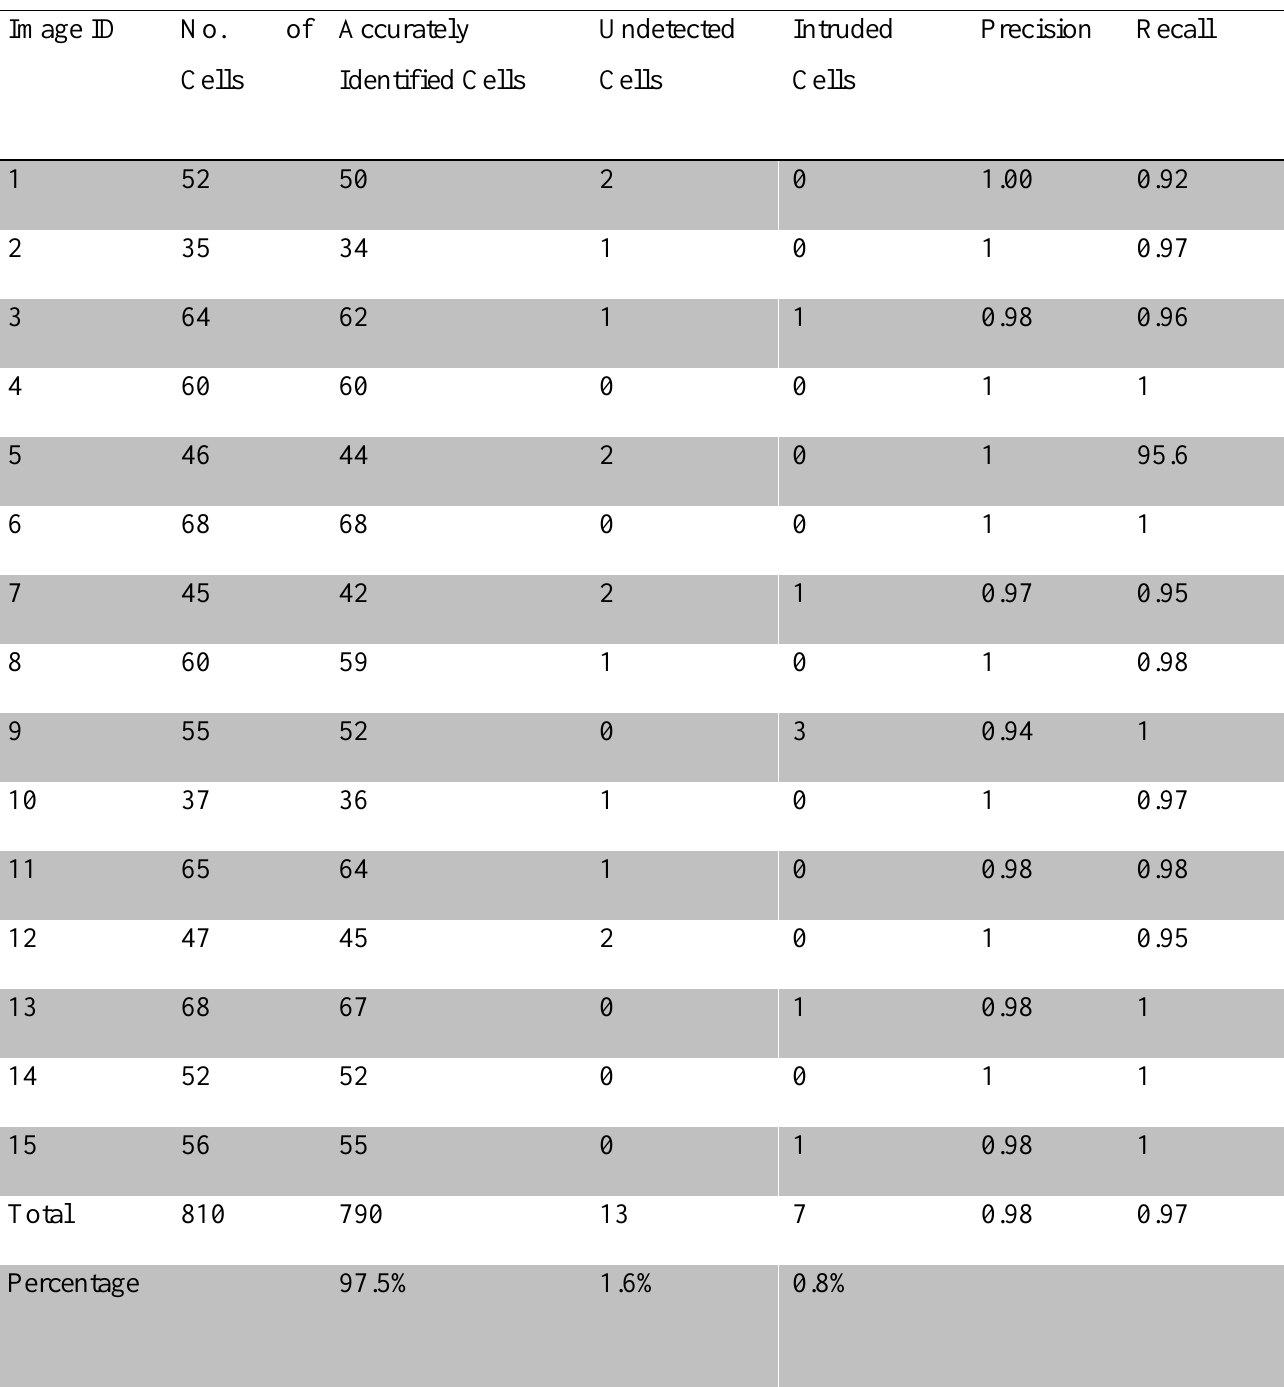
Table 1: Positive control images Class 1